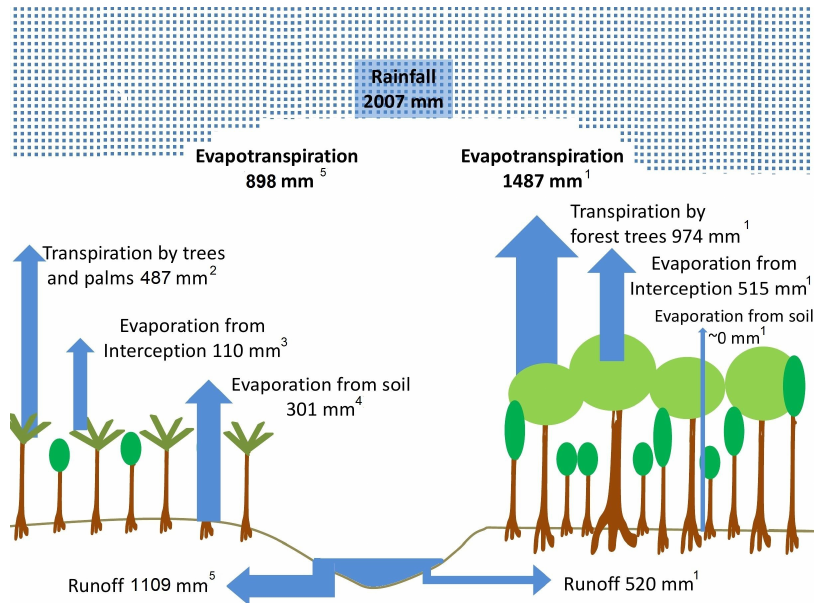
Figure 3. Changes in the water budget after forest conversion into fruit plantation. The origin and reference of the different values are given by the subscripted numbers. 1 Compiled after values given for Manaus by Salati and Vose [27] and Leopolodo et al. [28], we took the actual precipitation input of the year 2012, which differs only minimally from the original studies by Salati and Vose [27] and Leopolodo et al. [28]. 2 Estimates derived from measurements conducted by this study. 3 The intercept was assumed to scale with leaf area [29] (average leaf area in the planation 1.8 m 2 m − 2 and in the rainforest 8 m 2 m − 2 ), and the leaves in the plantation had intermediate interception properties. 4 Soil evaporation was assumed to be in accordance to average values found in tropical tree plantations